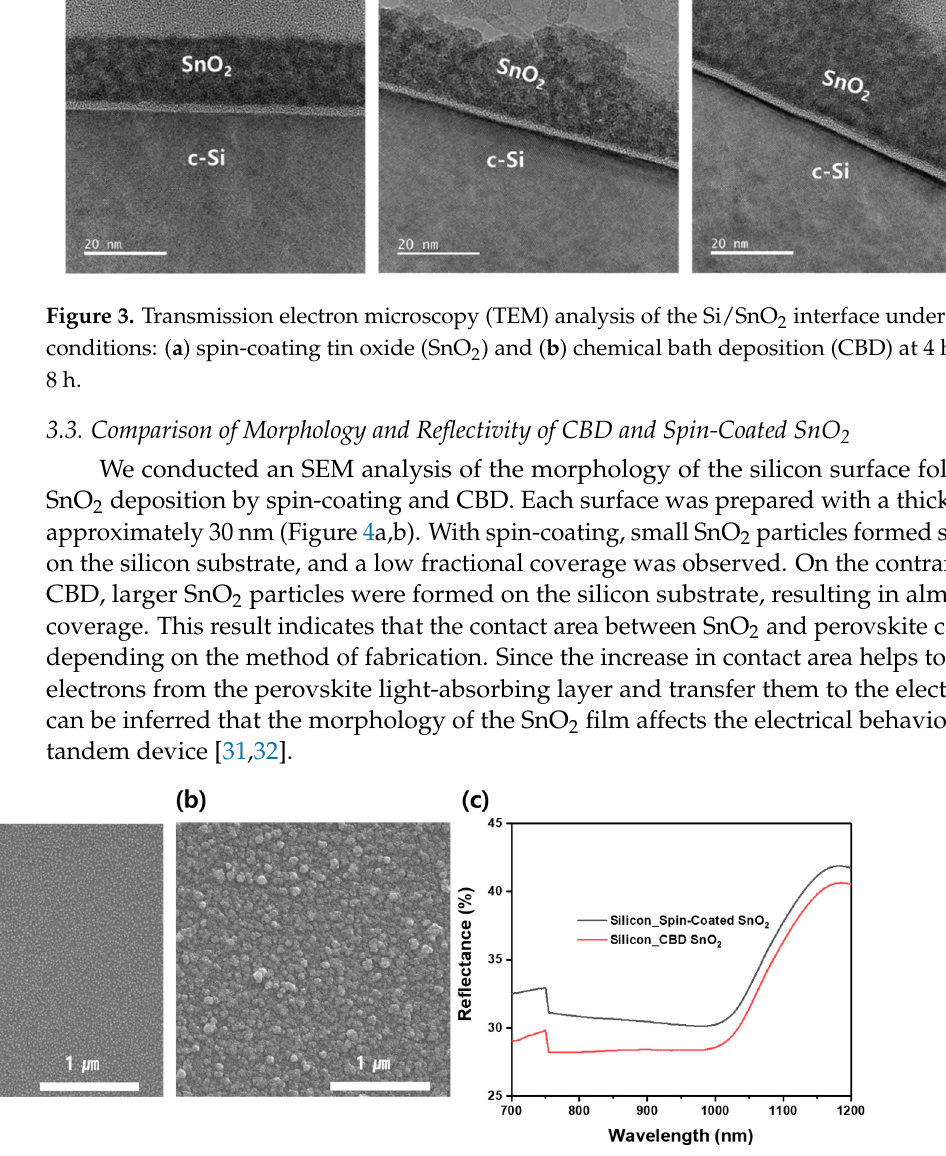
Figure 4. Scanning electron microscopy (SEM) images of SnO 2 deposited onto silicon substrates using ( a ) spin-coating and ( b ) chemical bath deposition (CBD) at 4 h. This sample was analyzed for reflectivity as well; ( c ) the reflectance curves of SnO 2 in the wavelength range of 700–1200 nm.